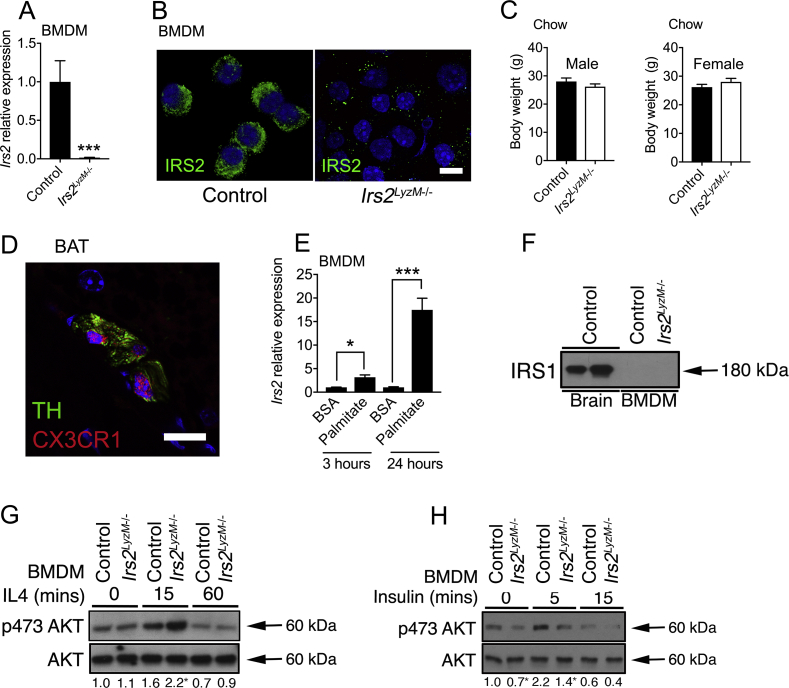
(A) Quantitative RT-PCR analysis of Irs2 mRNA expression in control and Irs2LyzM-/− BMDM. Hprt was used as an internal control (n = 5-6). (B) IRS2 immunostaining (green) in control and Irs2LyzM-/− BMDM. DAPI was used to visualize nuclei (blue). (3 mice/genotype). Scale bar = 10 μm. (C) Body weights of control and Irs2LyzM-/− male mice and female on chow diet at 23 weeks of age (n = 8). (D) TH (green) and CX3CR1 (red) immunostaining in BAT from wild type mice. DAPI was used to visualize nuclei (blue). Scale bar = 20 μm (E) Quantitative RT-PCR analysis of Irs2 mRNA expression in control BMDM treated with palmitate for 3 or 24 hours. BSA-treated BMDM were used as a control and Hprt mRNA was used as an internal gene control (n = 5-6). (F) Western blotting analysis of IRS1 expression in BMDM from control and Irs2LyzM-/−. Brain tissue lysates were used as a positive control. (G, H) Western blotting analysis of serine 473 phosphorylation of AKT in BMDM from control and Irs2LyzM-/− mice treated with IL4 (G) or insulin (H) for the times indicated. A representative blot is shown (n = 4-5). Mean values for band intensities in multiple samples quantified by densitometry are shown below the panel, relative to control samples for each time point. In all panels, data presented are mean ± SEM with Student’s t test for all panels. (*P < 0.05 and ***P < 0.001 relative to controls).